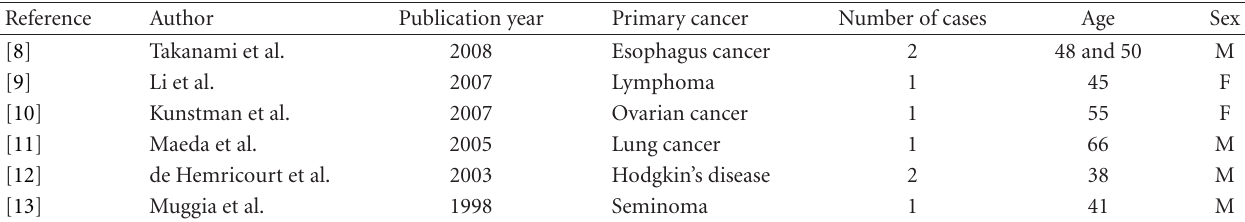
Table 1: Published sarcoidosis cases detected by 18 F FDG-PET ∗ study in cancer